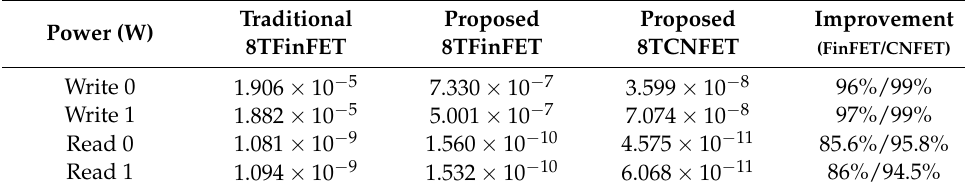
Table 6. Dynamic power consumption